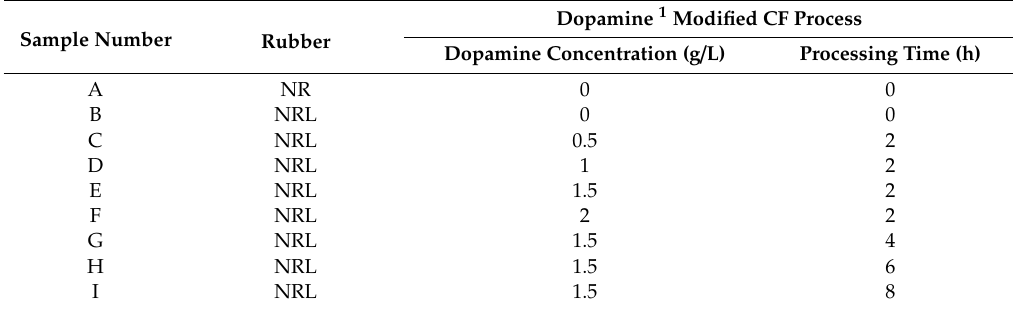
Table 1. Experimental scheme.